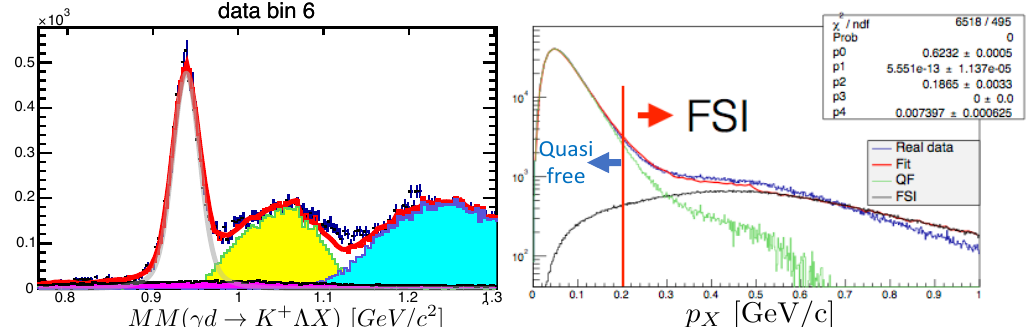
Figure 4: Left: Missing-mass distribution of γ d → K + Λ X indicated the various sources of background ( Σ channel with yellow, Σ ∗ channel with cyan, and acciden- tals with magenta). Right: Missing momentum of the reaction indicating the typical cut applied to select quasi-free or FSI- dominated samples.